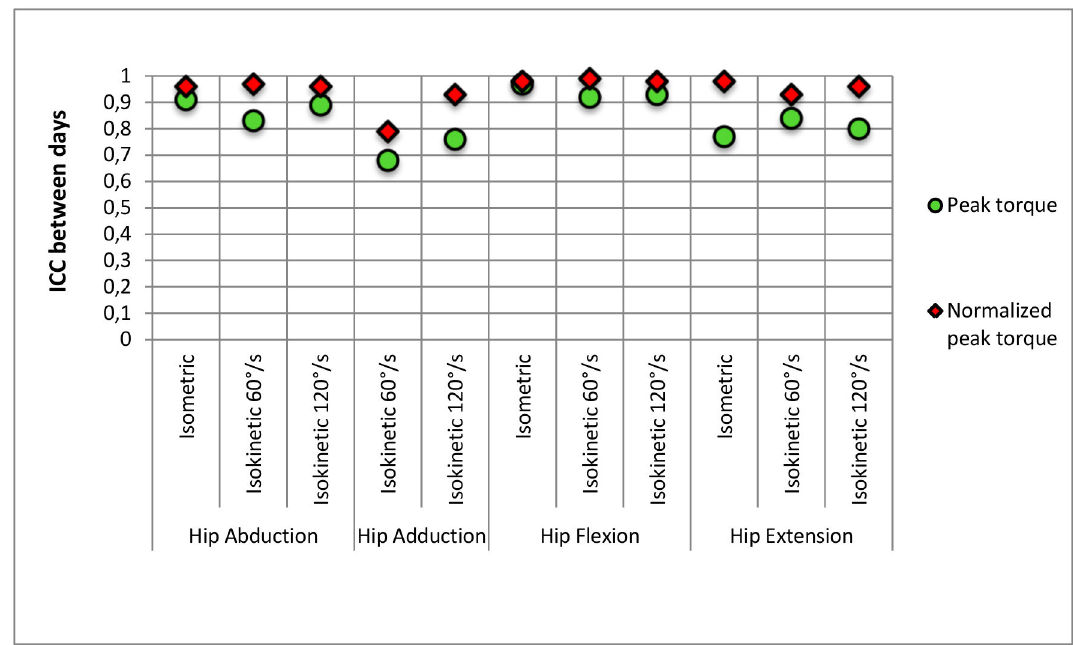
Figure 4. Reliability of isokinetic and isometric